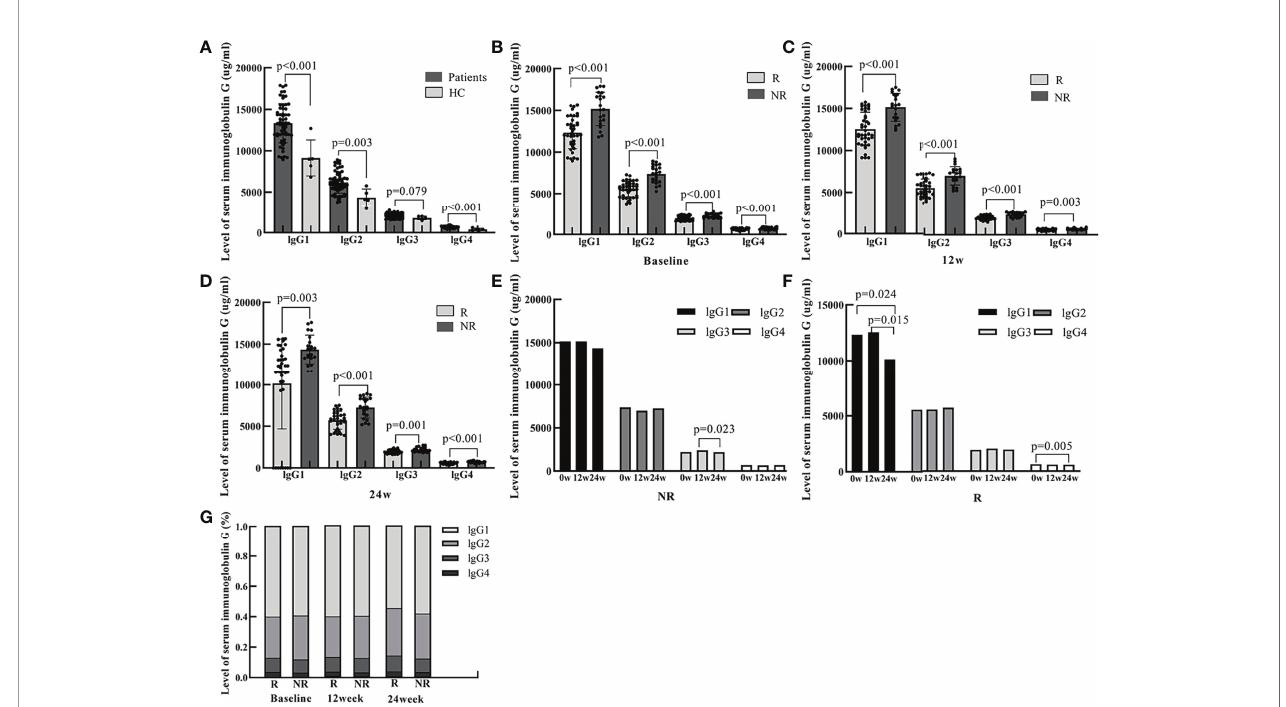
FIGURE 1 | The serum levels of IgG1, IgG2, IgG3, and IgG4 at baseline and 12 and 24 weeks of PEG-IFN treatment in IHCs and healthy controls. (A) The level of lgG1, lgG2, lgG3, lgG4 were signi fi cantly higher in IHCs than in healthy controls (p<0.001, p=0.003, p=0.079, p<0.001, respectively). (B) The levels of serum lgG1, lgG2, lgG3, and lgG4 were signi fi cantly lower in the R group than in the NR group at baseline (p<0.001, p<0.001, p<0.001, p<0.001, respectively). (C) The levels of serum lgG1, lgG2, lgG3, and lgG4 were signi fi cantly lower in the R group than in the NR group at week 12 of PEG-IFN treatment (p<0.001, p<0.001, p<0.001, and p=0.003, respectively). (D) The serum levels of lgG1, lgG2, lgG3, and lgG4 were signi fi cantly lower in the R group than in the NR group at week 24 of PEG-IFN treatment (p=0.003, p<0.001, p=0.001, and p<0.001, respectively). (E) The change in the serum levels of lgG1, lgG2 and lgG4 were not signi fi cant in the NR group. The serum levels of IgG3 was lower at week 24 of PEG-IFN treatment than at 12 weeks (p=0.023). (F) The serum levels of IgG1 were lower at week 24 of PEG-IFN treatment than at baseline and at 12 weeks (p=0.024 and p=0.015, respectively). (G) The proportion of lgG1, lgG2, lgG3 and lgG4 were not signi fi cant in the R and NR